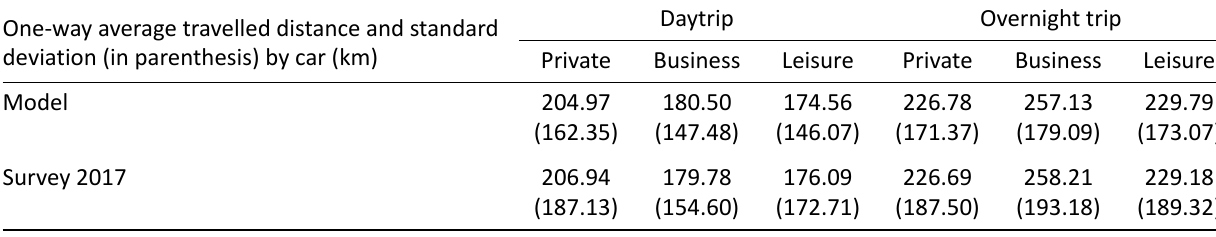
Table 3. Long‐distance destination choice model results. One‐way average travelled distance and standard deviation (in parenthesis) by car